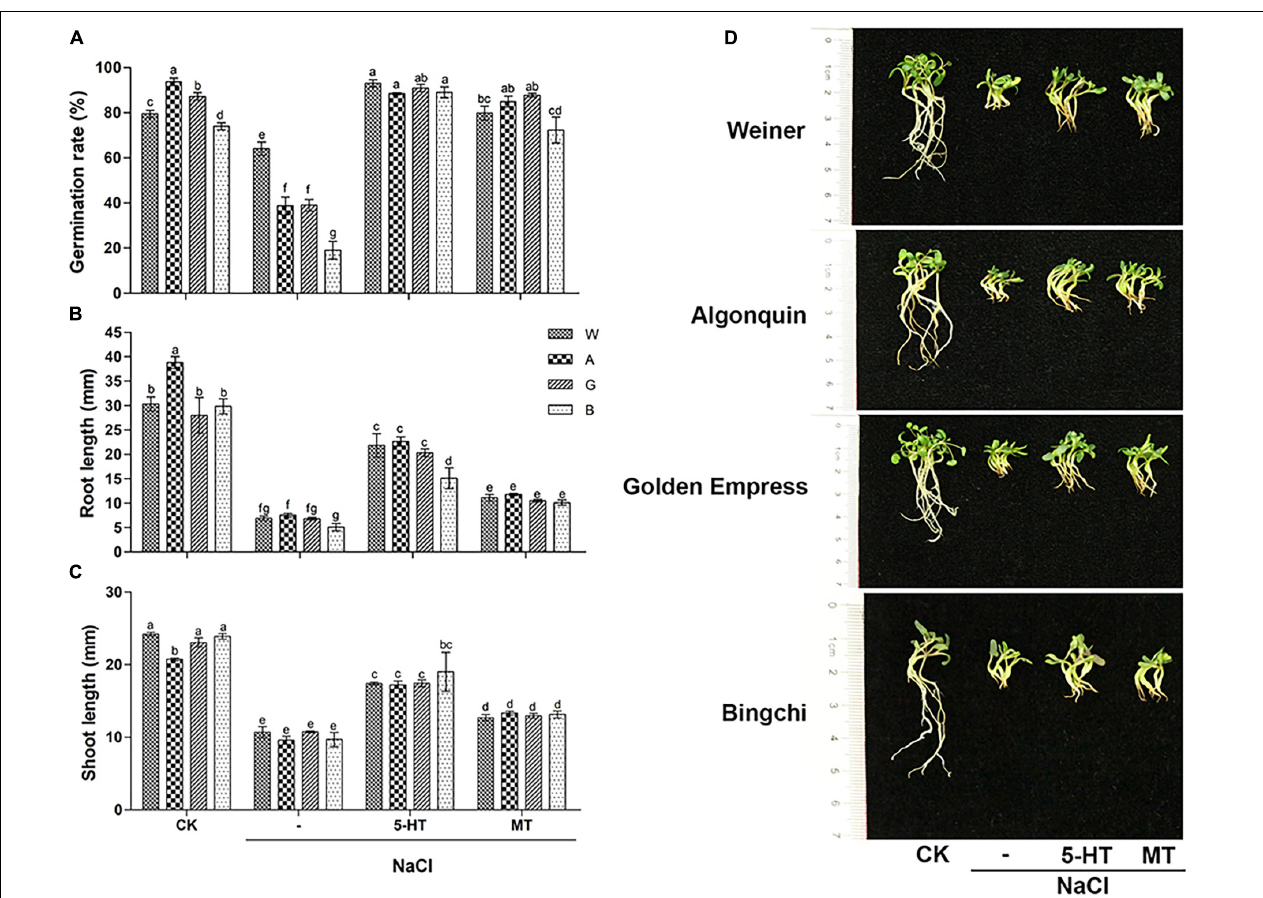
FIGURE 2 | Effects of melatonin (MT) and 5-HT treatment on seed germination and seedling growths of different alfalfa varieties under salt stress. CK: Water. NaCl: 250 mM. MT: 150 µ M. 5-HT: 1 µ M. Seeds were germinated for 10 days under different treatments, and germination rate, n = 200–500 (A) , root length, n = 30–40 (B) , shoot length, n = 30–40 (C) , and seedling phenotype (D) were shown. Error bars show the SE between biological replicates and a t -test was performed between different treatment groups. Different numbers indicated significant differences ( p (cid:53) 0.05) between samples. Representative seedlings were photographed and a scale bar was shown on the left. A, Algonquin; B, Bingchi; G, Golden Empress; W,